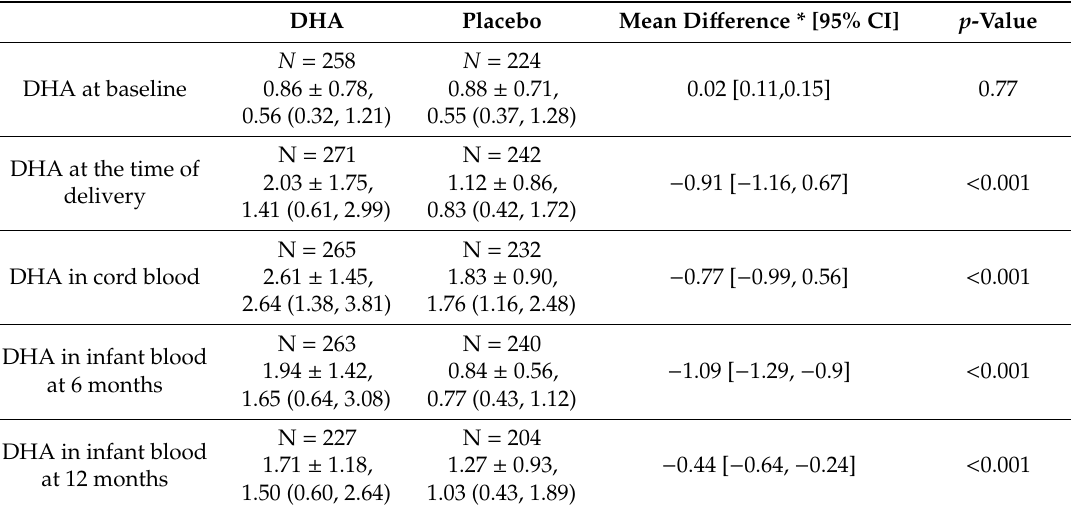
Table 4. Mean DHA (mol % of fatty acid) levels in RBC phospholipids. DHA